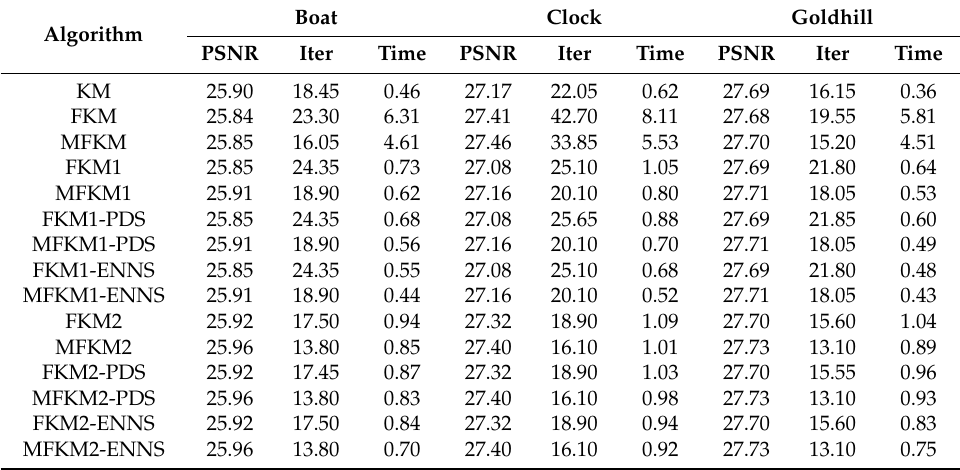
Table 5. PSNR (in dB), number of iterations and codebook design time (in seconds) for images Boat, Clock and Goldhill, using N =